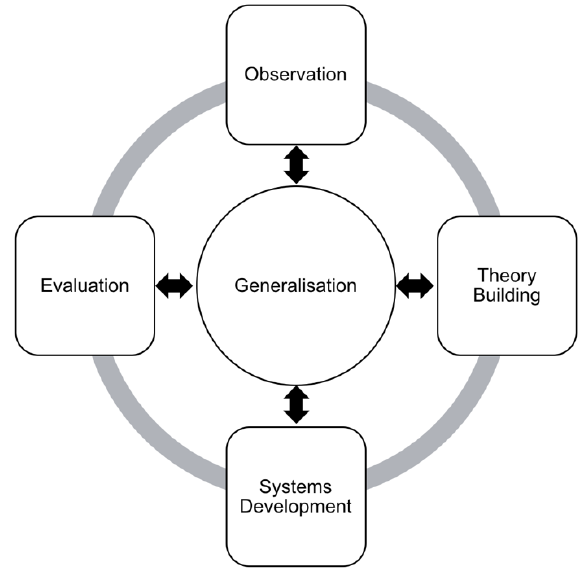
Figure 2. Research